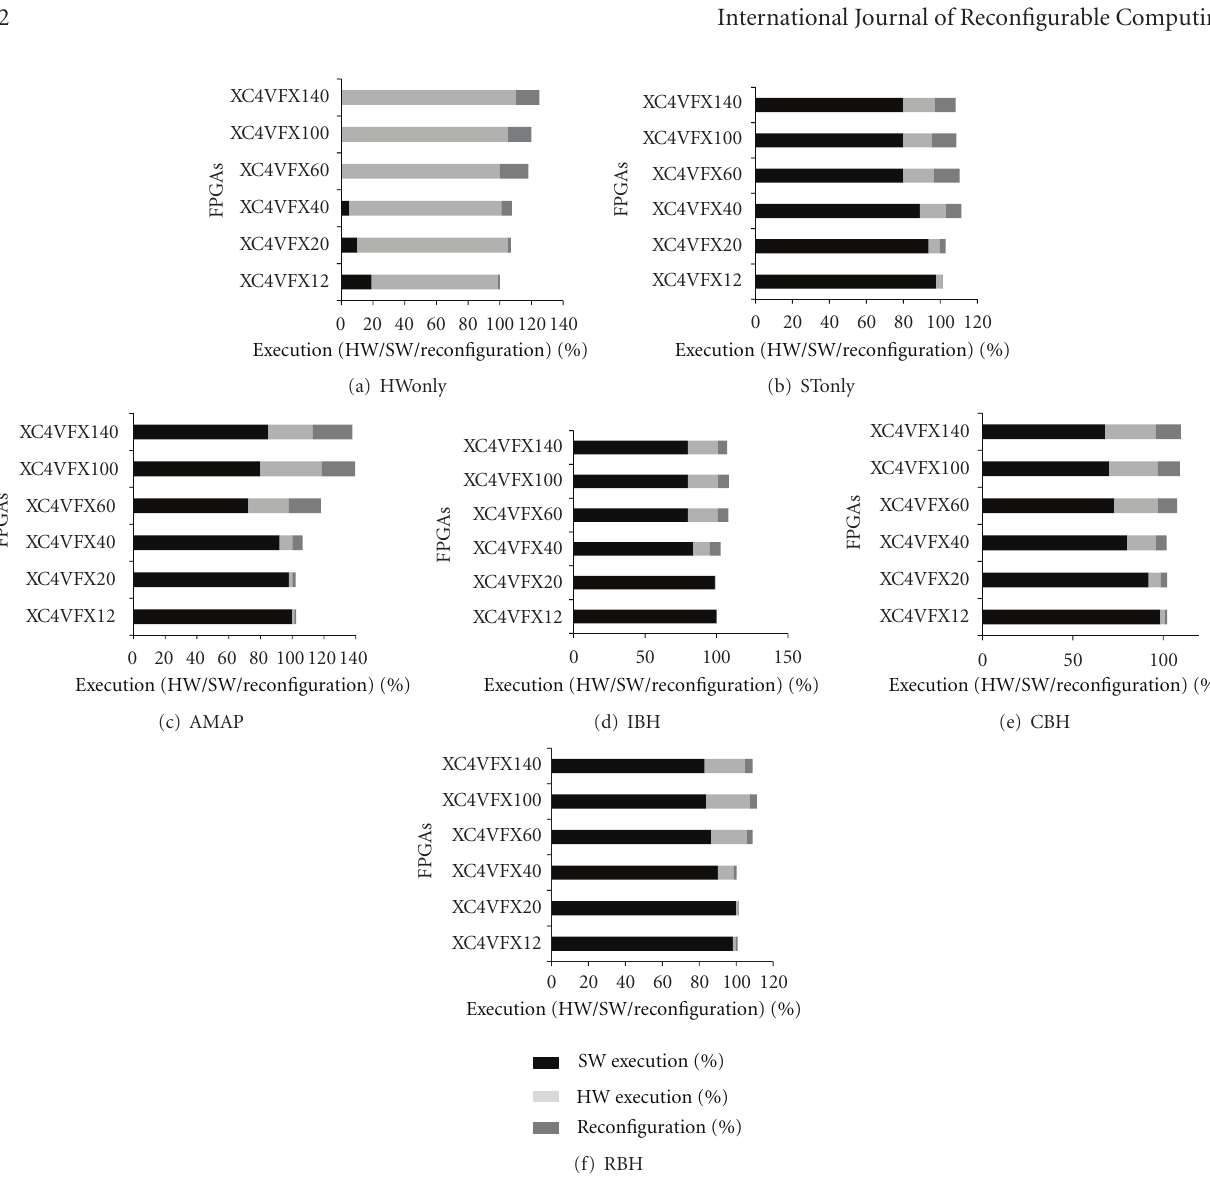
Figure 7: The comparison of di ff erent heuristics based on percentage of hardware execution, software execution, and reconfiguration. The hardware execution percentage is low in smaller FPGAs, and it increases considerably with more area